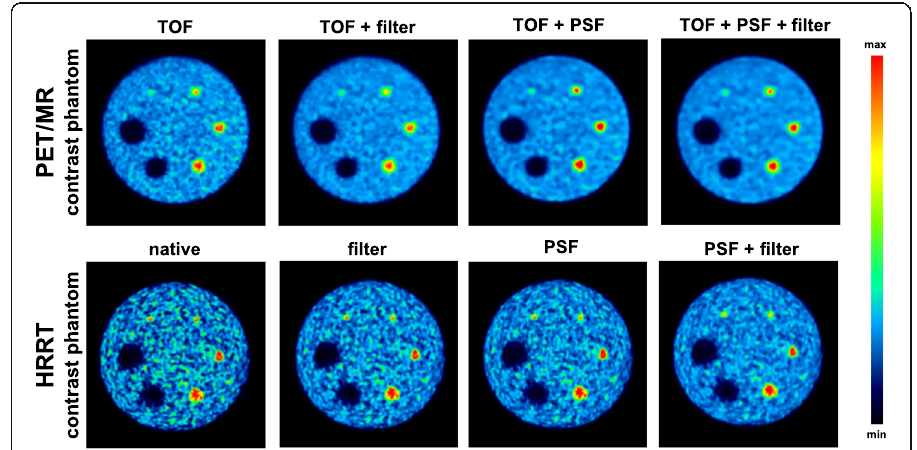
Fig. 1 Representative images of the contrast phantom data for different reconstruction parameters for the two systems. Color scales of the images were normalized based on the average background value multiplied by the respective sphere to background